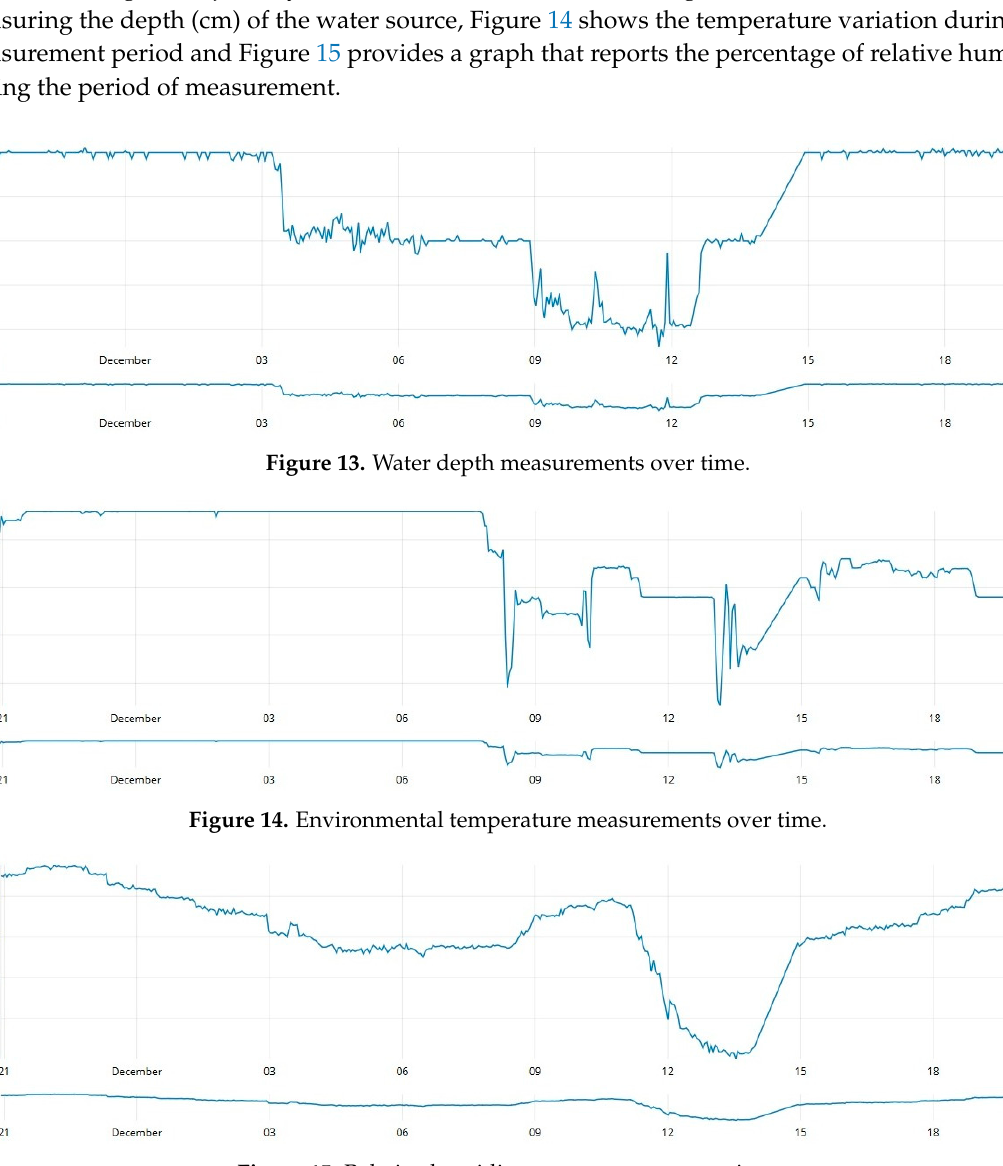
Figure 15. Relative humidity measurements over time.